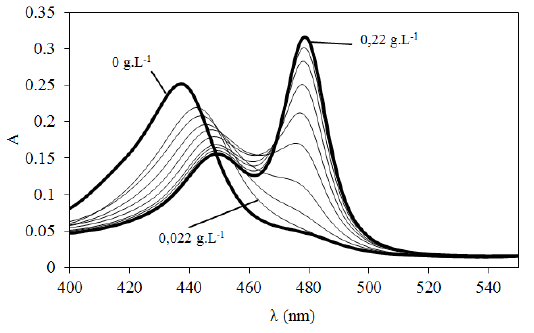
Figure 4. Spectral changes during the measurement of the calibration curve of Triton CF-21; thin curves are spectra for increasing concentrations (absorbance are marked at fixed wavelength in the Fig. 3); curve for 0 g L -1 represents absorption spectra of Pb(II)-T(DBHP)P coloration complex without any